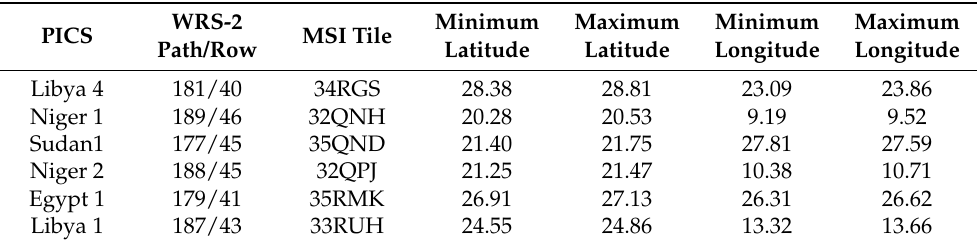
Table 2. Location of study areas, including the WRS-2 Path/Row, UTM/WGS84 Tiles, and ROI coordinates.